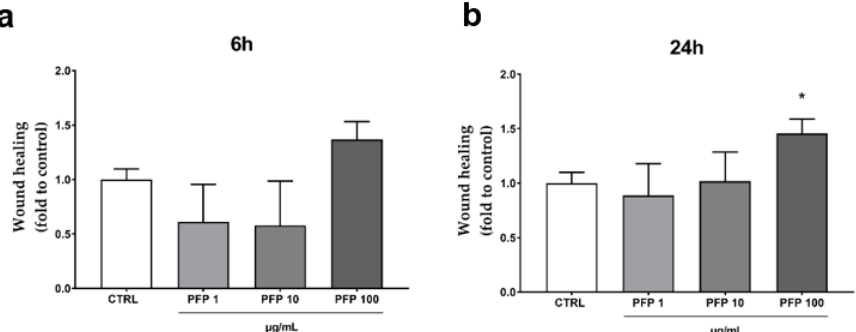
Figure 4. Wound Healing assay in HaCaT cells treated with PFP (1, 10, 100 µg/mL) for 6 h ( a ) and 24 h ( b ) or untreated (CTRL). Each column represents mean ± SD. Data were analyzed by one-way analysis of variance followed by Tukey: * p < 0.05 vs. CTRL.